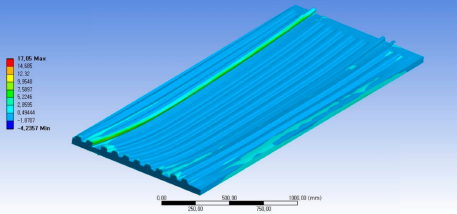
Figure 13. Stress analysis result of load case 1-Maximum principal stress 17.05